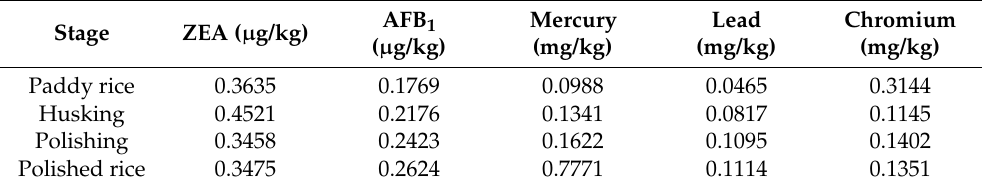
Table 5. Combined weights.